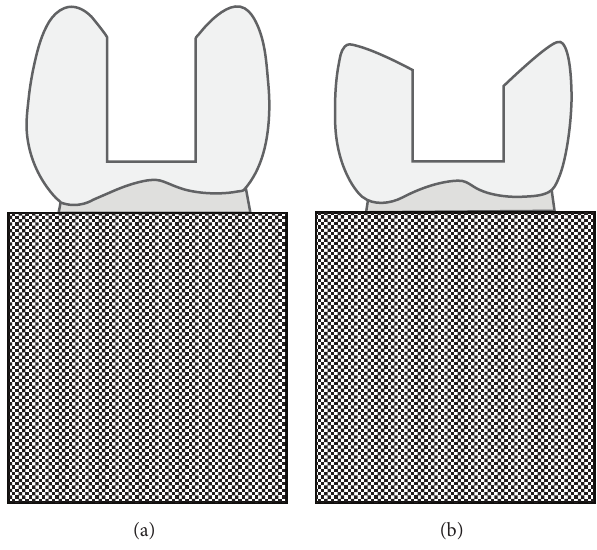
Figure 1: Specimens without (a) and with (b) cusp reduction as described by Lia Mondelli et al.